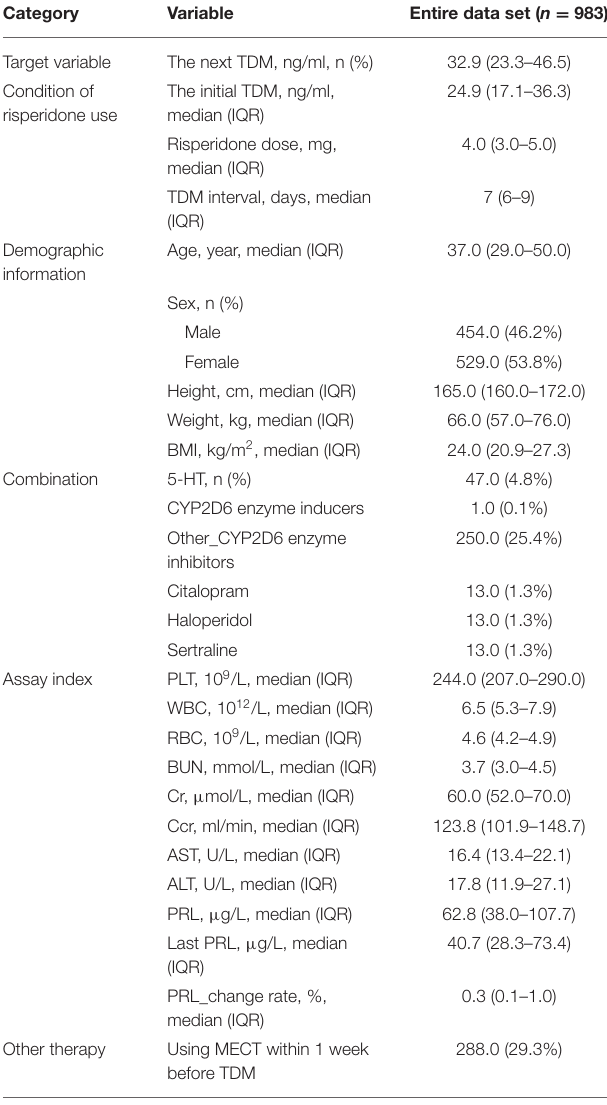
TABLE 1 | Baseline characteristics of study